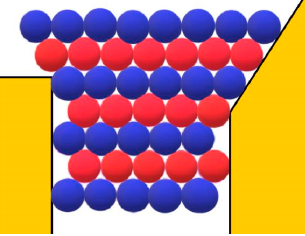
Figure 7. HCP protein crystal growing outside a pore with an inclined surface, shown on the right side of the pore. The adsorption of protein molecules on this surface facilitates the growth of the next crystal layer.